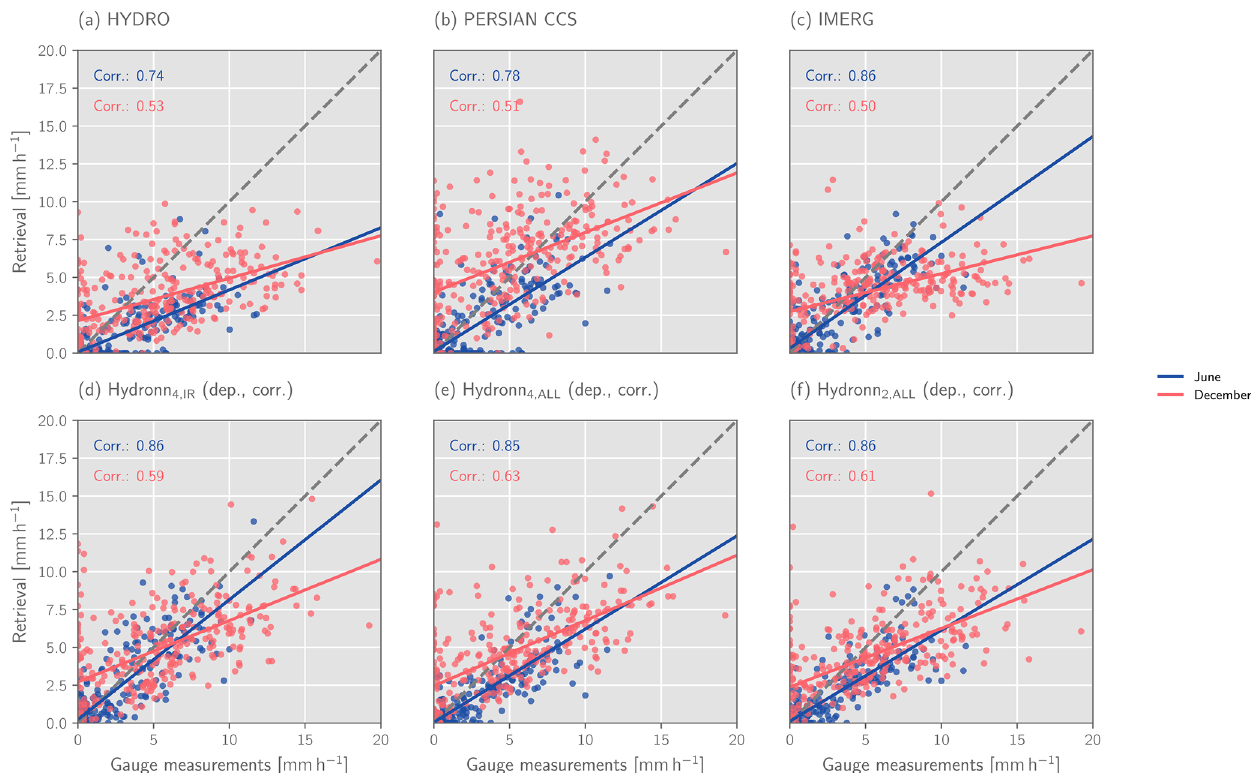
Figure 20. Scatter plots of the 99th percentile of the monthly distribution of hourly precipitation accumulations of each gauge station for June (blue) and December (red) plotted against the 99th percentile of the corresponding retrieved distribution of precipitation accumulations. The results of the Hydronn retrievals use samples from the posterior distribution of hourly accumulations obtained assuming dependent retrieval errors instead of the posterior